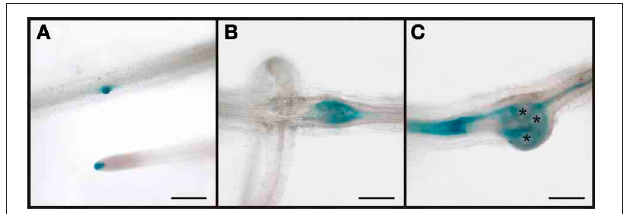
FIGURE 4 | Auxin response visualized by GUS-staining in M. incognita infected P DR5 :GUS plant roots. (A) uninfected parts of the root displayed a normal staining pattern. The tissue within the root-knot 7dai (B) and 17dai (C) displayed an auxin response. Giant cells (asterisks in C ) were not stained. Scale bars represent 200 µ m.